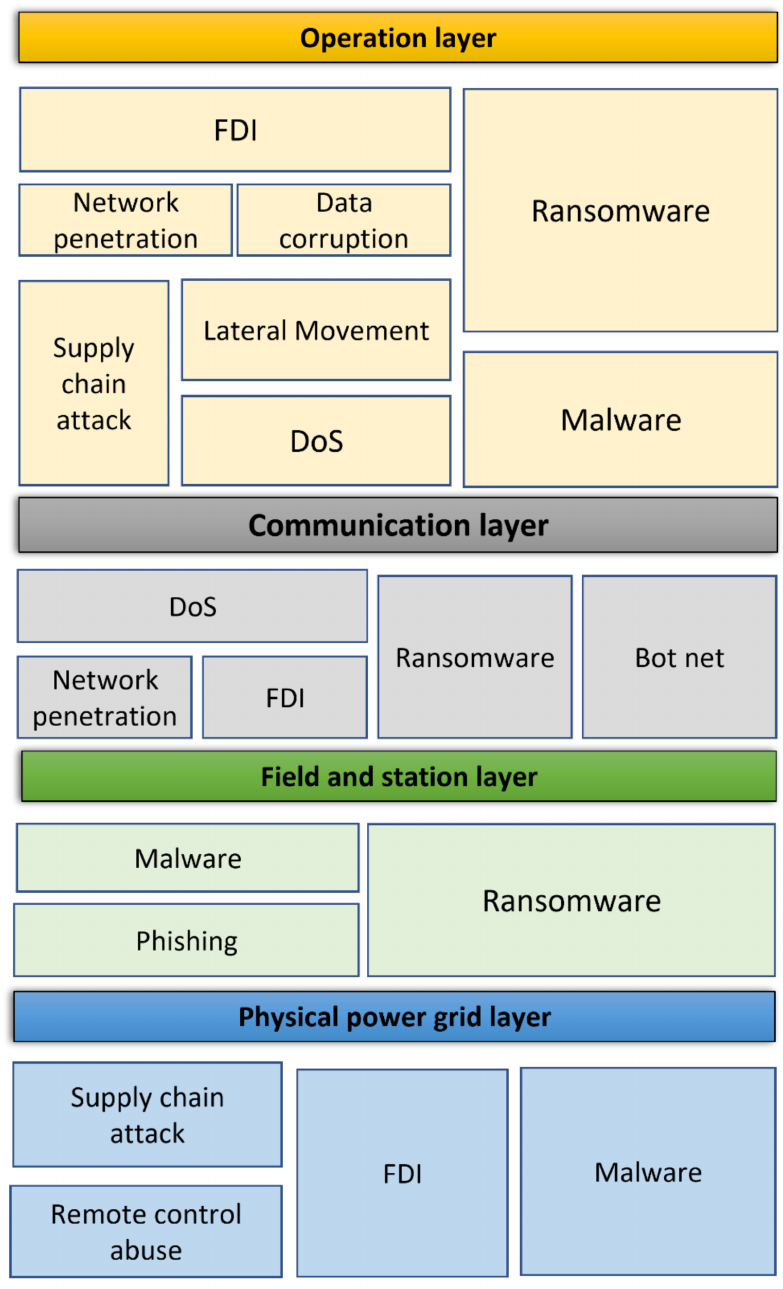
Figure 5. Tree map of the most significant threats on different power grid